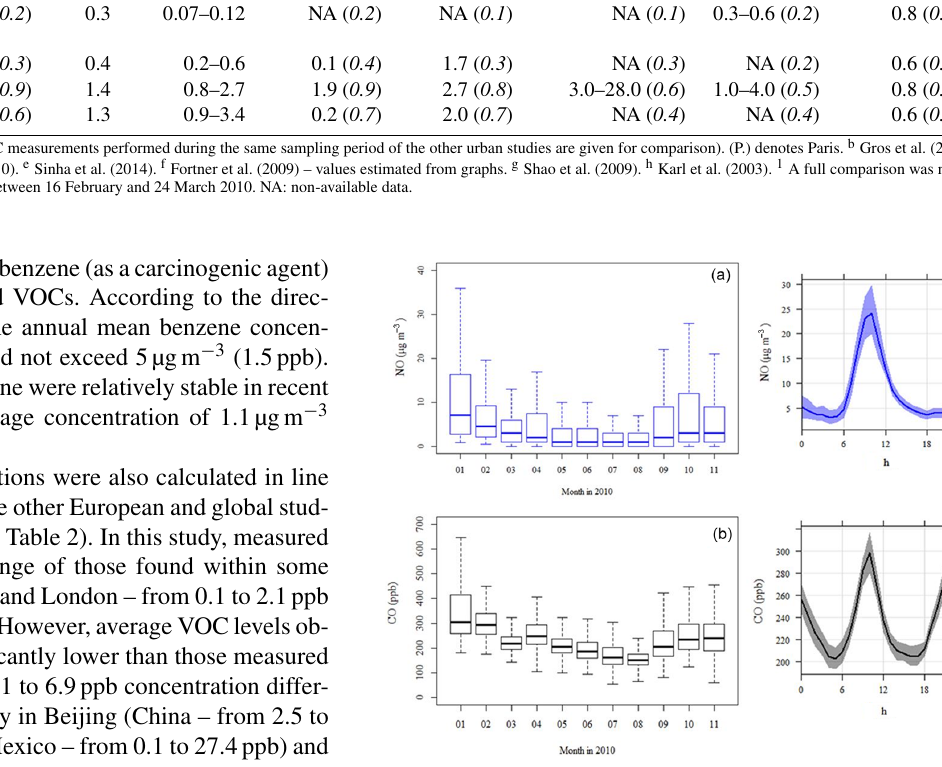
Figure 6. Left: monthly box and whisker plots of NO (a) and CO (b) expressed in µgm − 3 and ppb, respectively. Solid lines represent the median concentration and the box shows the interquartile range (IQR). The bottom and top of the box depict the 25th (the first quar- tile) and the 75th (the third quartile) percentile. The ends of the whiskers correspond to the lowest and highest data still within 1.5 times the IQR of Q1 and Q3, respectively. Right: diurnal variations of NO and CO averaged over the whole sampling period. Time is given as local time. Lines correspond to hourly means and shaded areas indicate the 95% confidence intervals of the